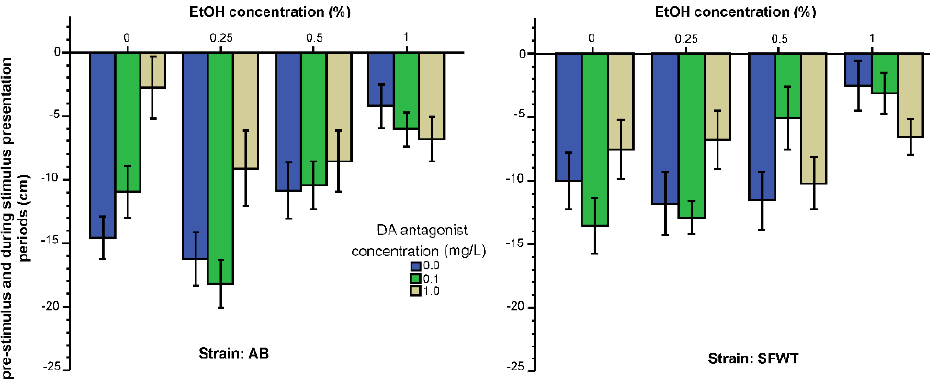
Figure 1. Change of distance to stimulus screen elicited by the presentation of animated conspecific images is influenced by the concentration of acute alcohol (X-axis) and the concentration of acute D1-R antagonist (legend) in an interactive manner. Mean ± S.E.M. are shown.